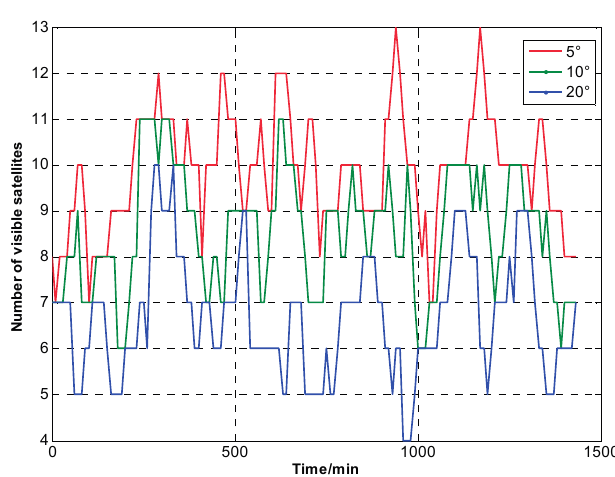
Figure 2. GNSS orbit model.